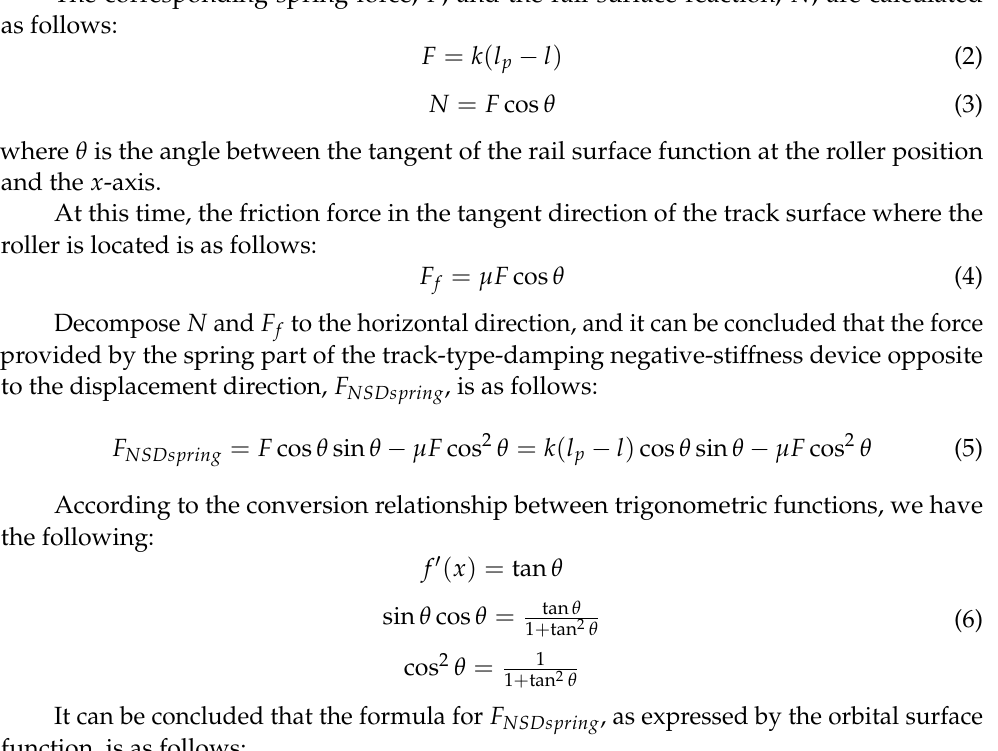
Figure 3. Stress-state analysis of roller.